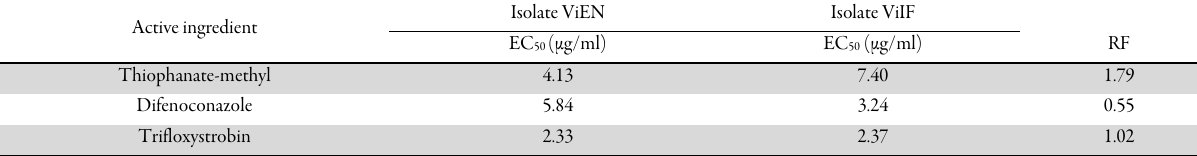
Table 2 . Sensitivity of V. inaequalis isolates to thiophanate-methyl, difenoconazole andTrifloxystrobin Active ingredient